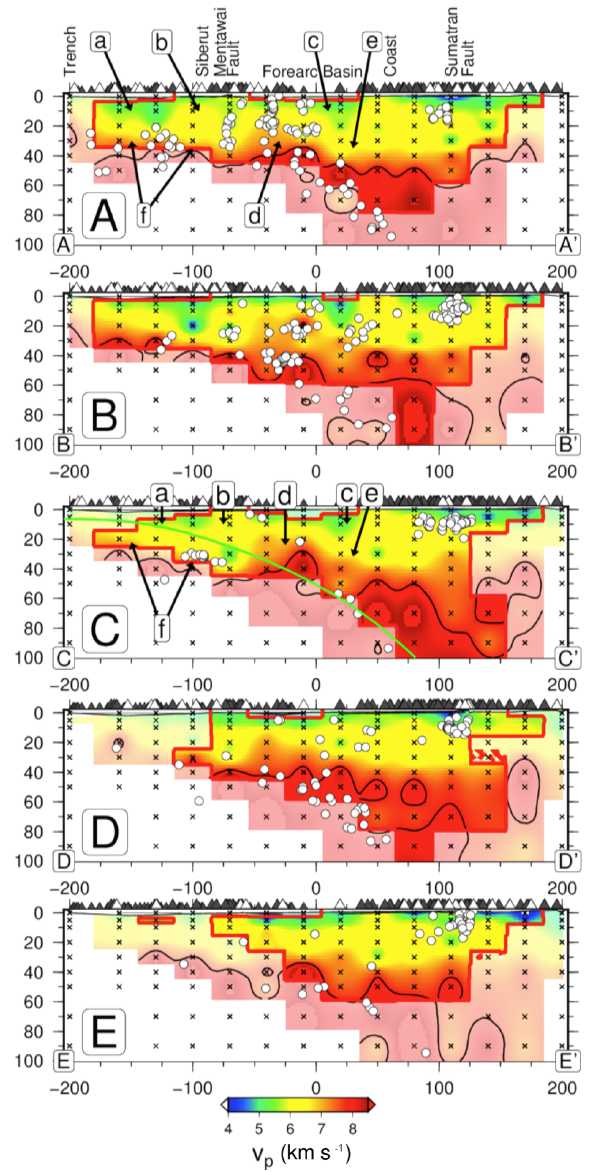
files through the 3-D v p model. See Fig. 9a for location of cross sections. White circles indicate events within 10km of the profile and stations closer than 25km to the profile are shown by white triangles, the remaining ones by black triangles. The 46 OBS sta- tions of the 2-week deployment are shown with smaller triangles. Grid nodes are shown with crosses. Red lines encircle regions of good resolution defined by a cut-off spread value of 1.5. Green line in panel (c) indicates the plate interface as defined by the global SLAB1.0 model (Hayes et al., 2012). The 7.8kms − 1 v p contour line is indicated by a black line. See text for explanation of charac- ters. Other symbols as in Fig. 6. Note that the geographic labels at the top refer to all profiles, but that only profiles C (Batu Islands) and E (Siberut) actually cross a forearc